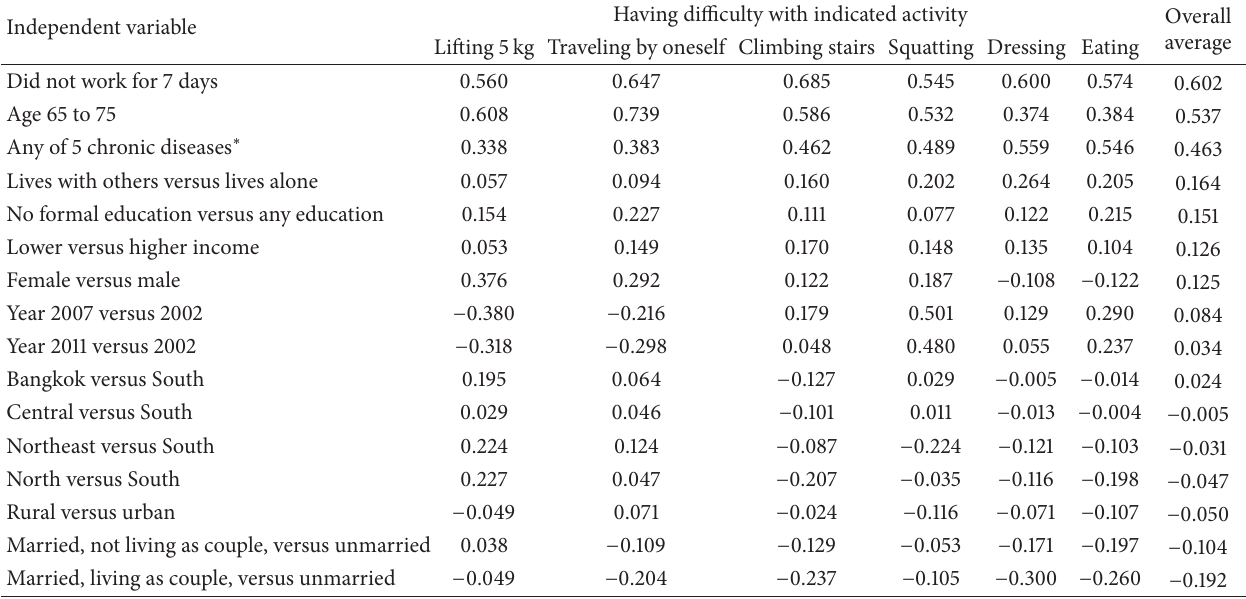
Table 5: Proportional impacts of independent variables on prevalence of six disabilities in the elderly in Thailand in 2002, 2007, and 2011. Independent variable